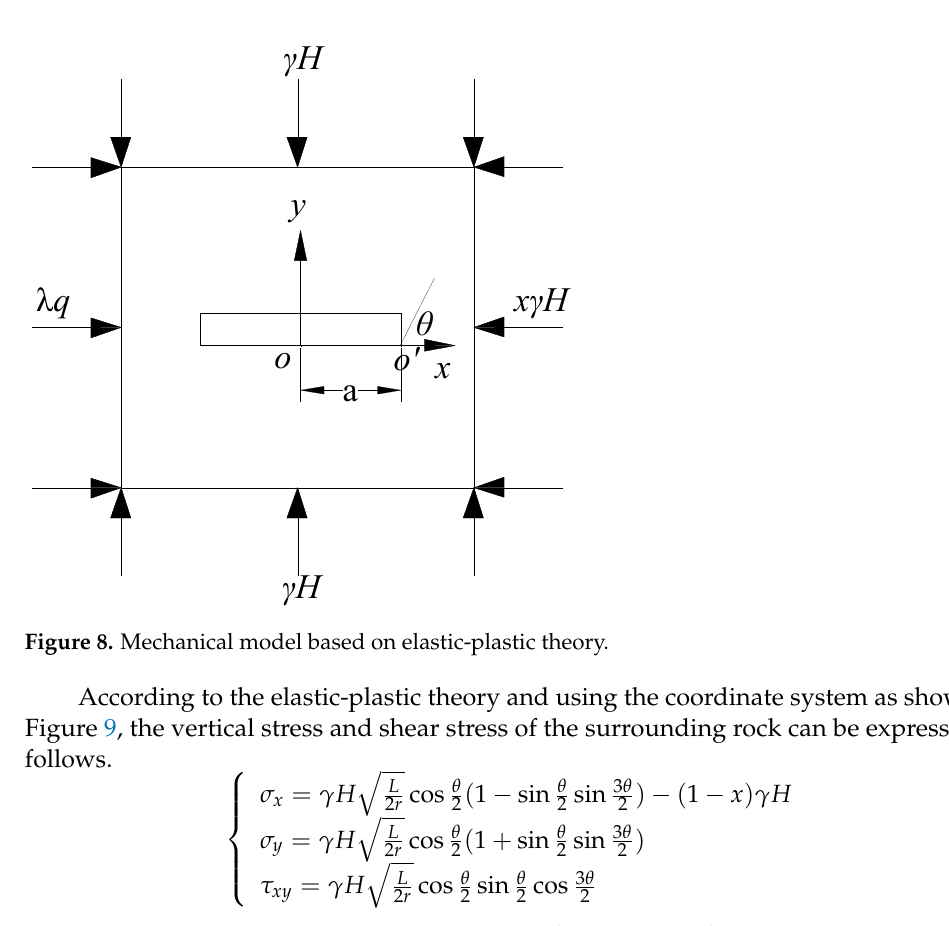
where L and H are the length and buried depth of the working face, γ is the bulk density of rock mass, x is lateral stress ratio, r is the limit failure distance ahead of the working face, θ is the angle between the edge line and the horizontal direction at the maximum yield depth h .